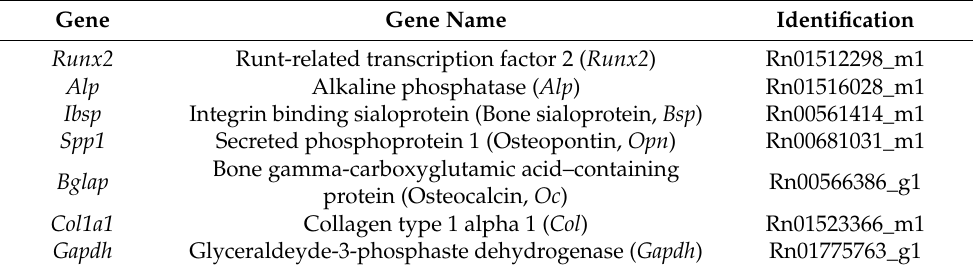
Table 2. TaqMan primers used for real-time PCR